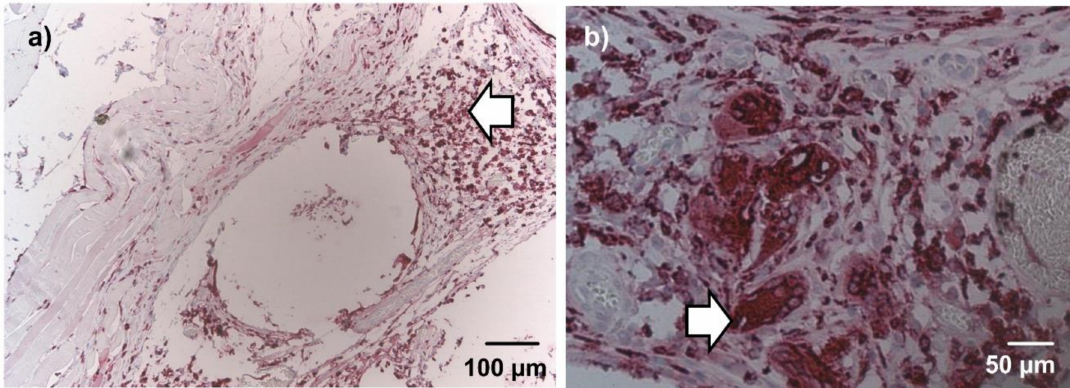
Figure 5. ED1 (CD68) immunohistochemical staining after 4 weeks, 10 × ( a ) and 20 × magnification ( b ), representative images (not all groups are depicted). A low number of ED1 positive cells was present in the granulation tissue ( a ; arrow). Few foreign body giant cells were detected in single constructs ( b ; arrow). No differences were evident between groups with nBG and without nBG in qualitative microscopic evaluation.